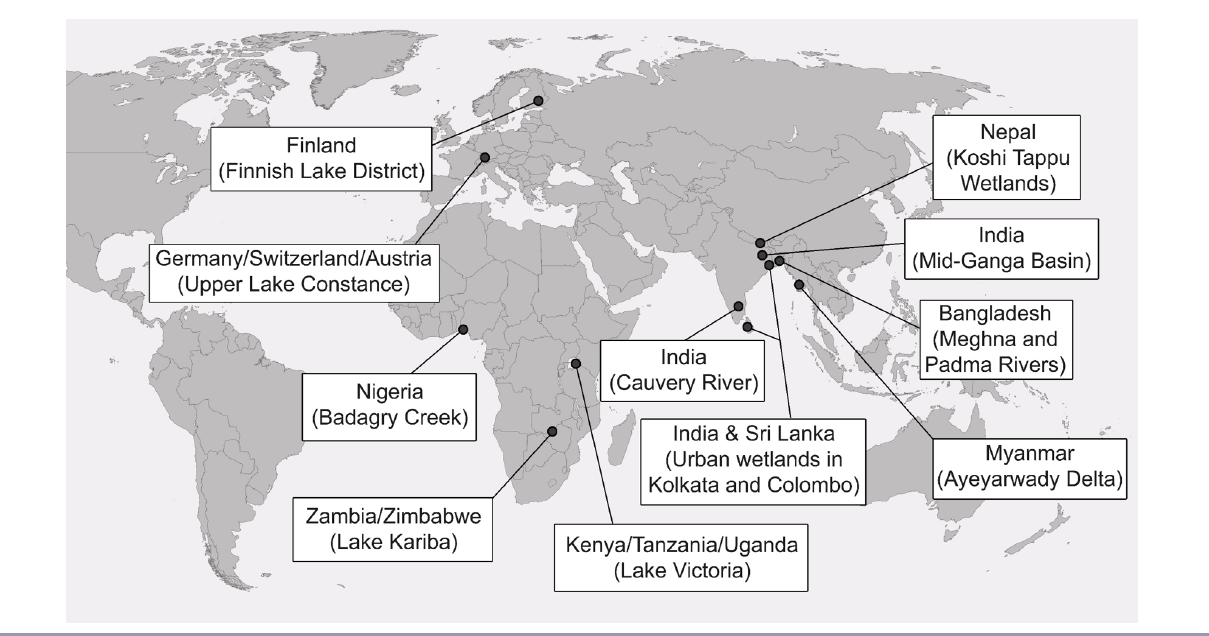
Fig. 1. Map showing case study